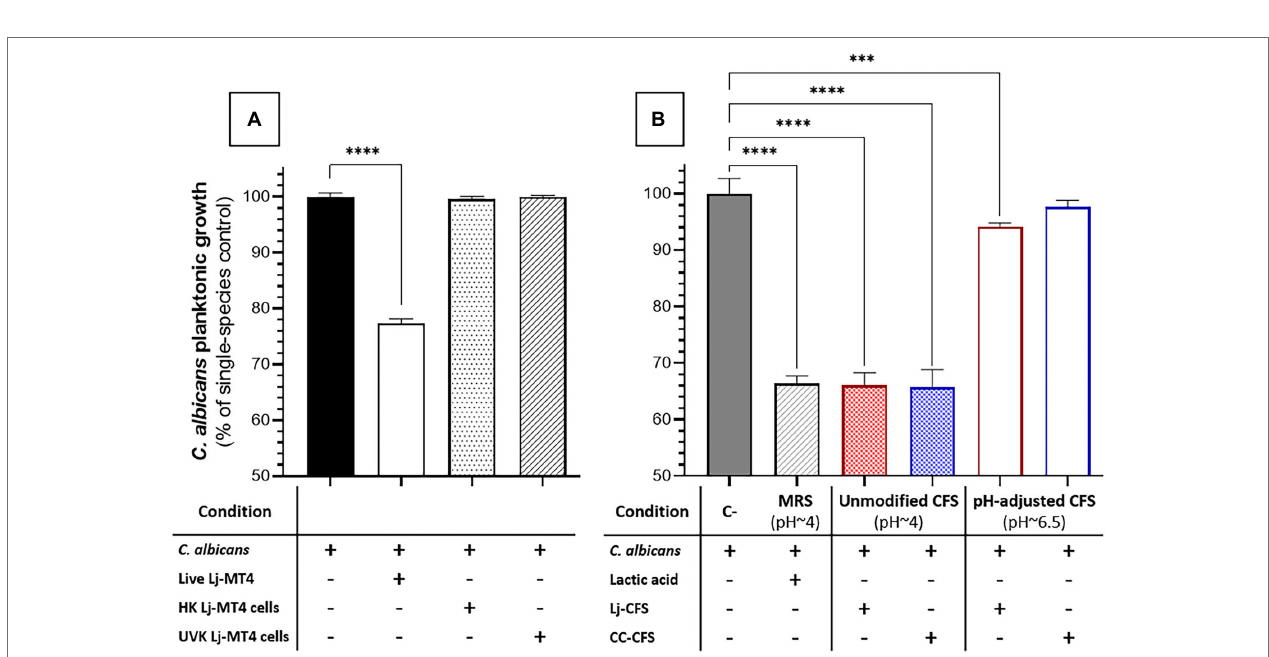
FIGURE 6 | Effect of L. johnsonii inactivated cells and soluble metabolites on C. albicans growth in MRS broth. (A) Inactivated L. johnsonii cells did not reduce the growth of C. albicans ; (B) L. johnsonii CFS inhibited the growth of C. albicans in a pH-dependent manner. HK = heat killed, UVK=UV-killed. CFS = Cell-free supernatant (spent media). One-Way ANOVA, Dunnett posttest, *** p ≤ 0.005, **** p ≤ 0.0001. 100% growth corresponds to 8.16 ± 0.41 SD yeast cells ml − 1 in MRS